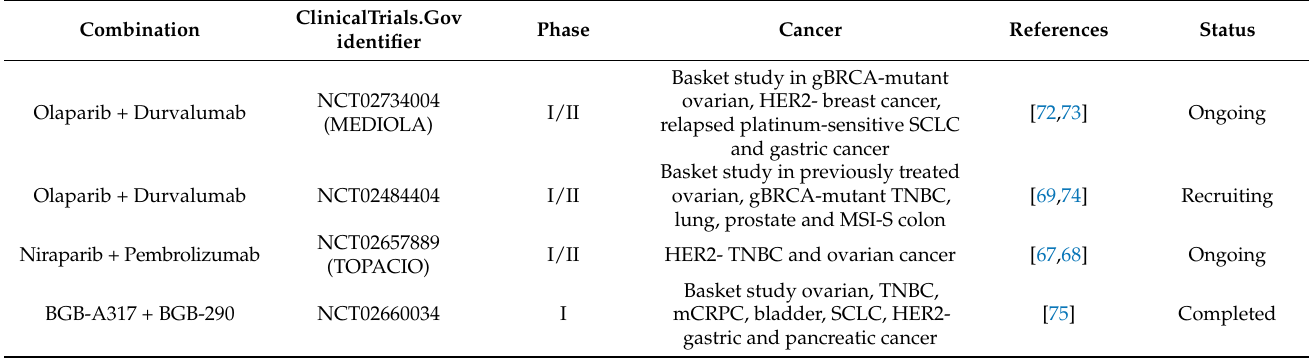
Table 3. Combination studies with available